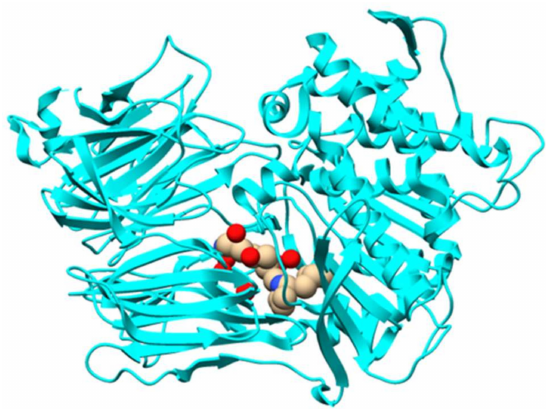
Figure 15. Overall structure of peptide cyclase PCY1 with follower peptide (PDB